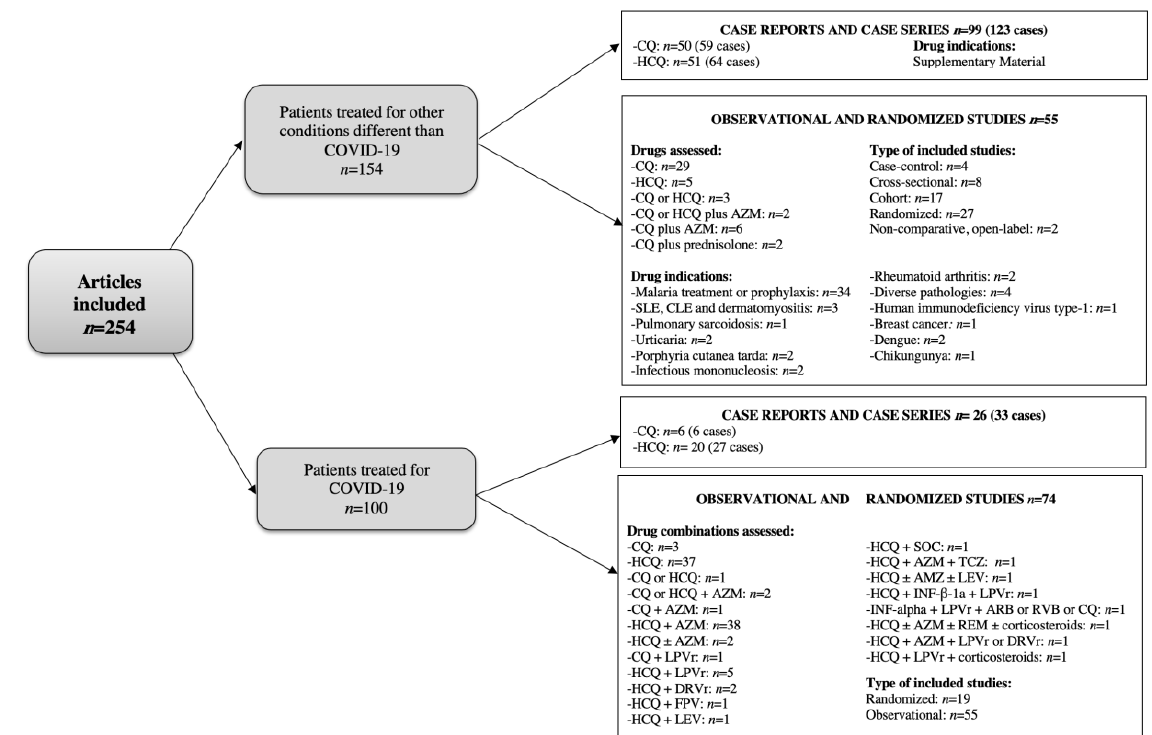
Figure 2. Study characteristics and results of individual studies, flow